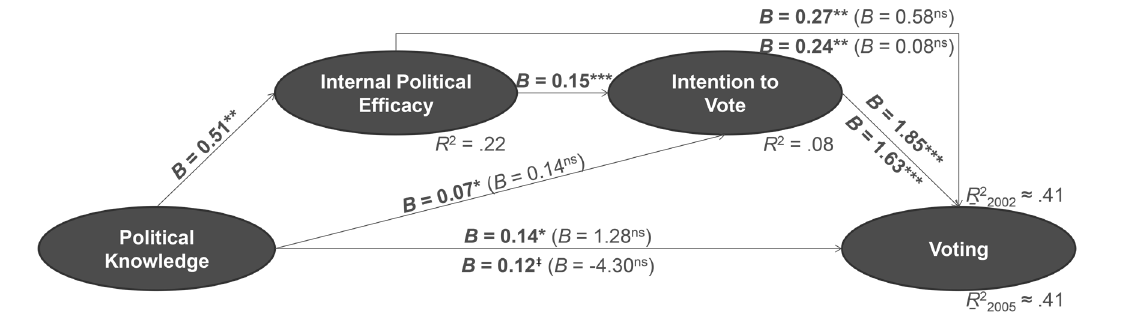
Figure 1. Prediction of voting in the federal election by political knowledge, sequentially mediated through internal political efficacy and intention to vote (effects on voting in 2002 above lines; effects on voting in 2005 below lines; pre-election sample with n = 1,195). Note. Unstandardized regression weights; direct effects in mediated regressions in